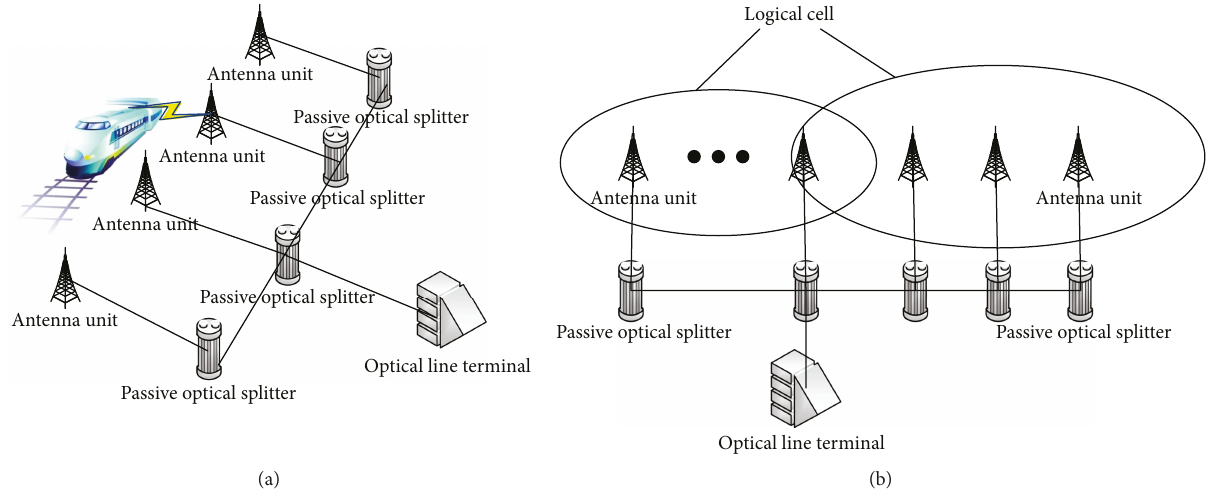
Figure 1: DAS used for mobile communication of the high-speed railway: (a) DAS of the high-speed railway and (b) logical cells of the DAS. Table 1: Introductions of the parameters used in Section